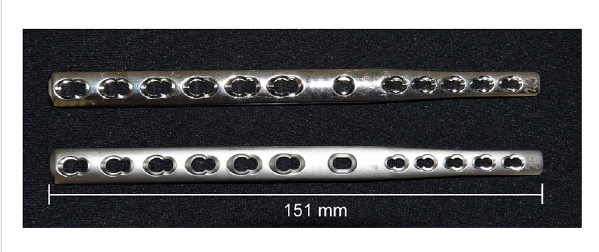
FIGURE 1 LCP Pancarpal Arthrodesis Plate 2.7/3.5 mm with round (up) and oval(down) standardradiocarpalscrewhole, 12 holes,length 151 mm.